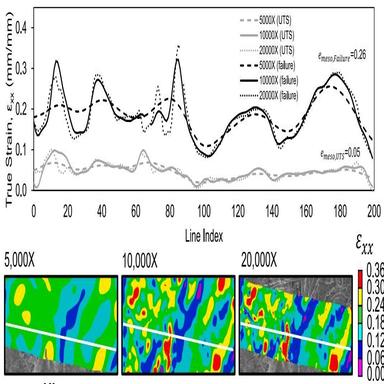
μDIC analysis for MS1500 at 5,000×, 10,000×, and 20,000×. The contour image is taken at emeso,failure and the white line is the scan line used to produce the strain distribution plot.